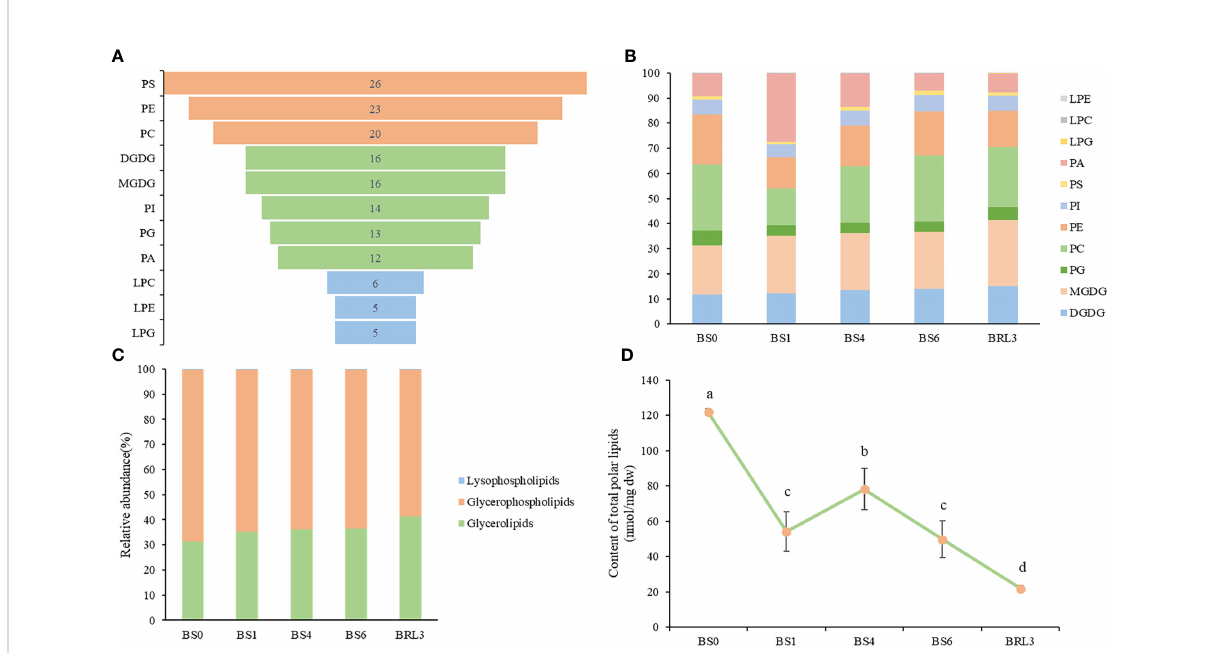
FIGURE 3 Overall lipidomics analysis of in BJG. (A) Distribution of each lipid subclass identi fi ed. (B) Changes of lipid subclasses in BJG after shading and light recovery treatments. (C) Lipid categories identi fi ed in BJG after shading and light recovery treatments. (D) Changes in the content of total polar lipids after shading and light recovery treatments. Data and error bars are the mean ± SD (n = 3). Different lowercase letters indicate a signi fi cant difference between the means at P